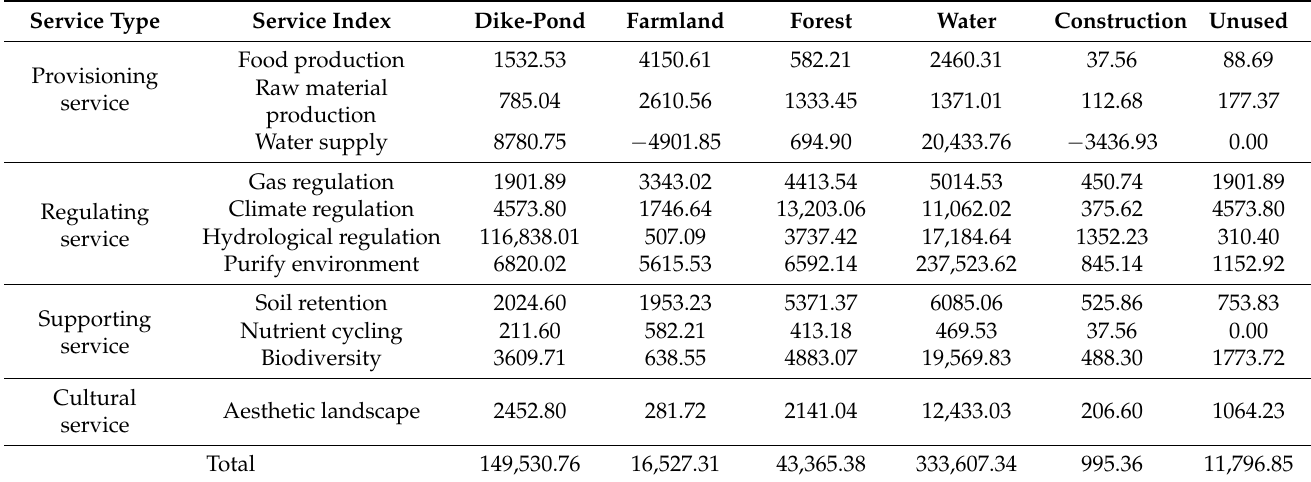
Table 5. Ecosystem service value coefficient per unit area in Shunde District (CNY/hm 2 ).